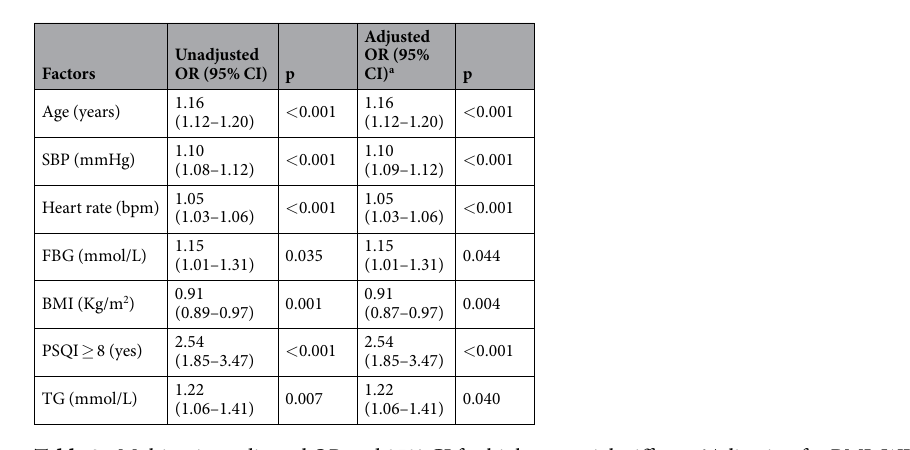
Table 3. Multivariate adjusted OR and 95% CI for higher arterial stiffness. a Adjusting for BMI, WHR, SBP, DBP, PP, hypertension, diabetes mellitus, TG, TC, HDL, LDL, FBG, menopause, income, employment status, parity, marital